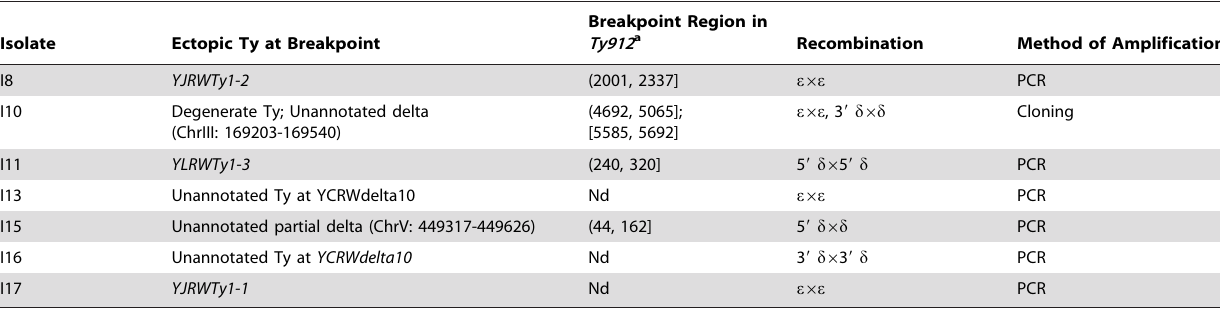
Table 4. Analysis of SNPs in Ty fusion